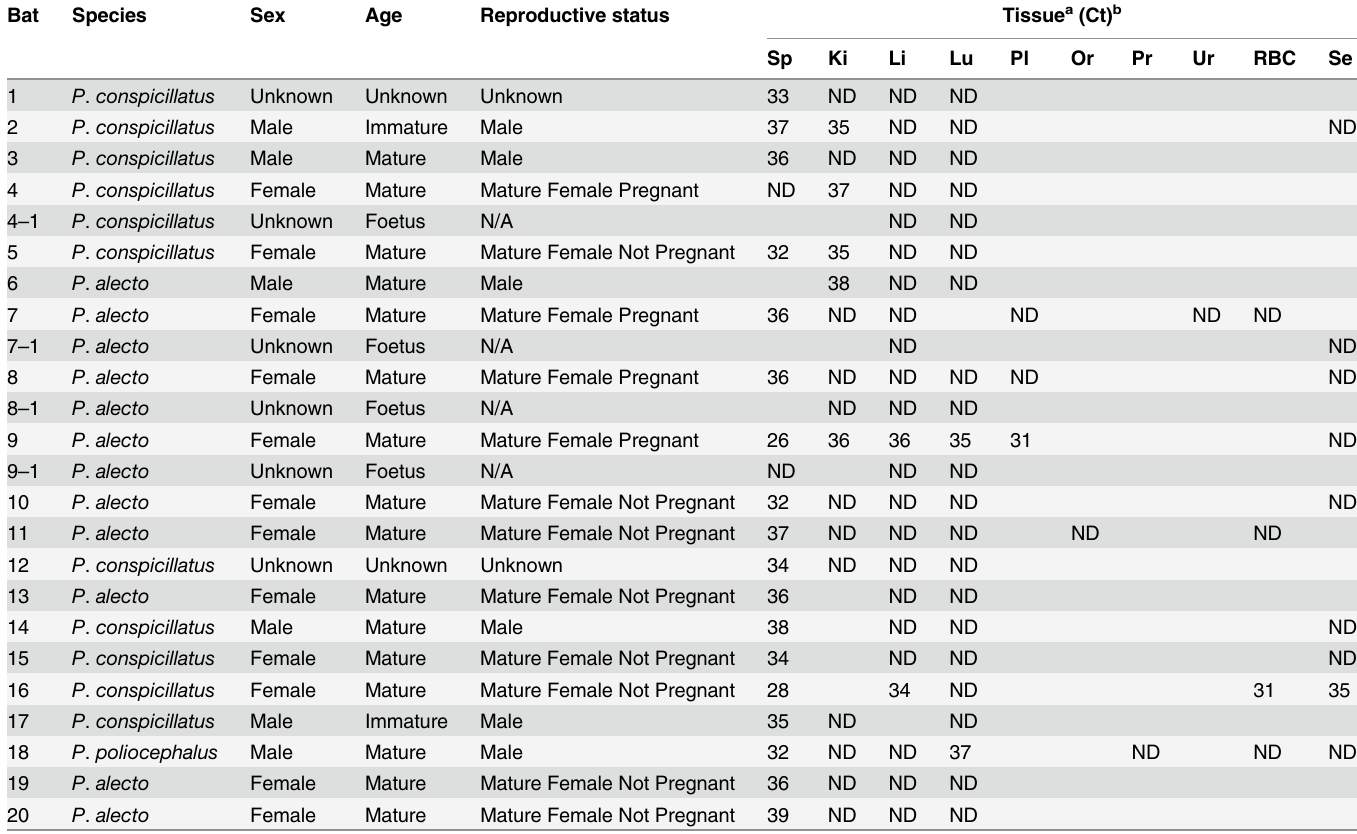
Table 2. Description and results for 20 Hendra virus positive flying-foxes tested by RT-qPCR.